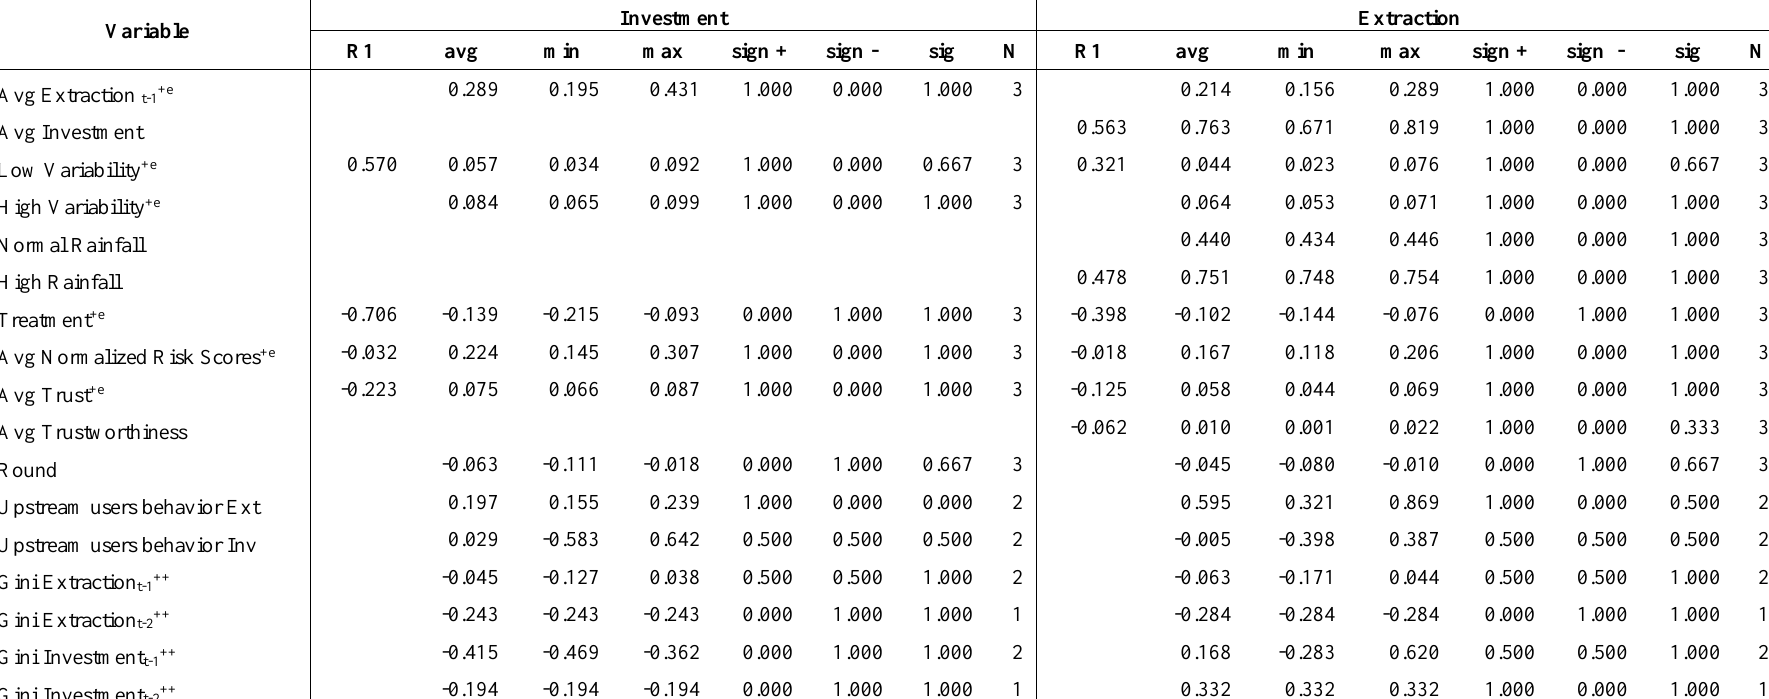
Table S5: Summary for system coefficients at the Group